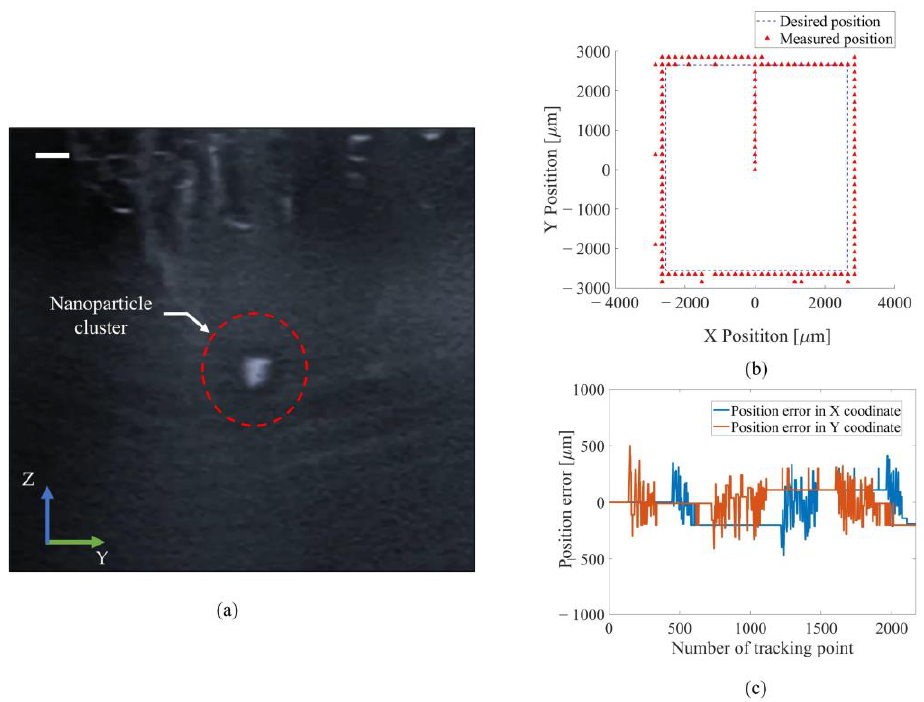
Figure 9. Demonstration of trapping and manipulating nanoparticles under ultrasound imaging: ( a ) the ultrasound imaging of nanoparticles; ( b ) the measured position of nanoparticles following preprogramed trajectory in the O-XY plane; ( c ) the position error in the O-XY plane (scale bar: 3 mm).